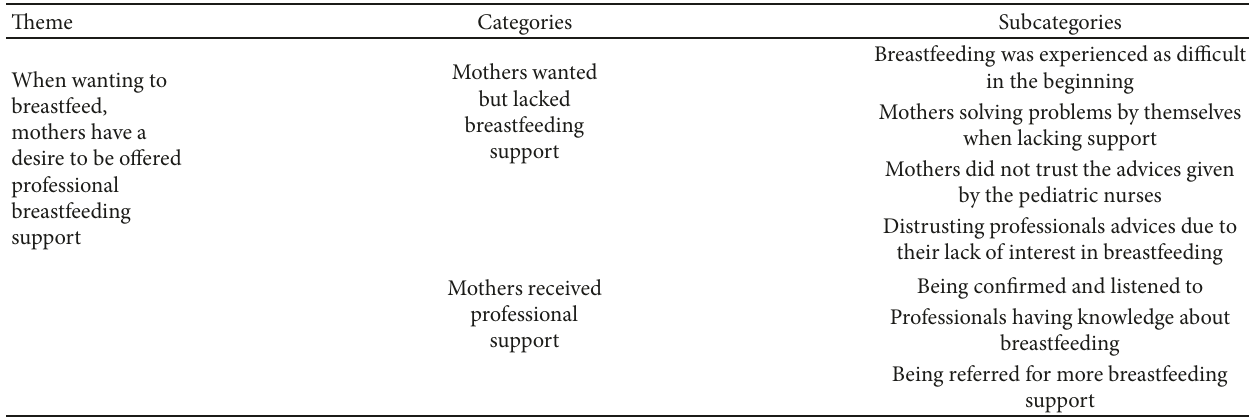
Table 2: Overview of theme, categories, and